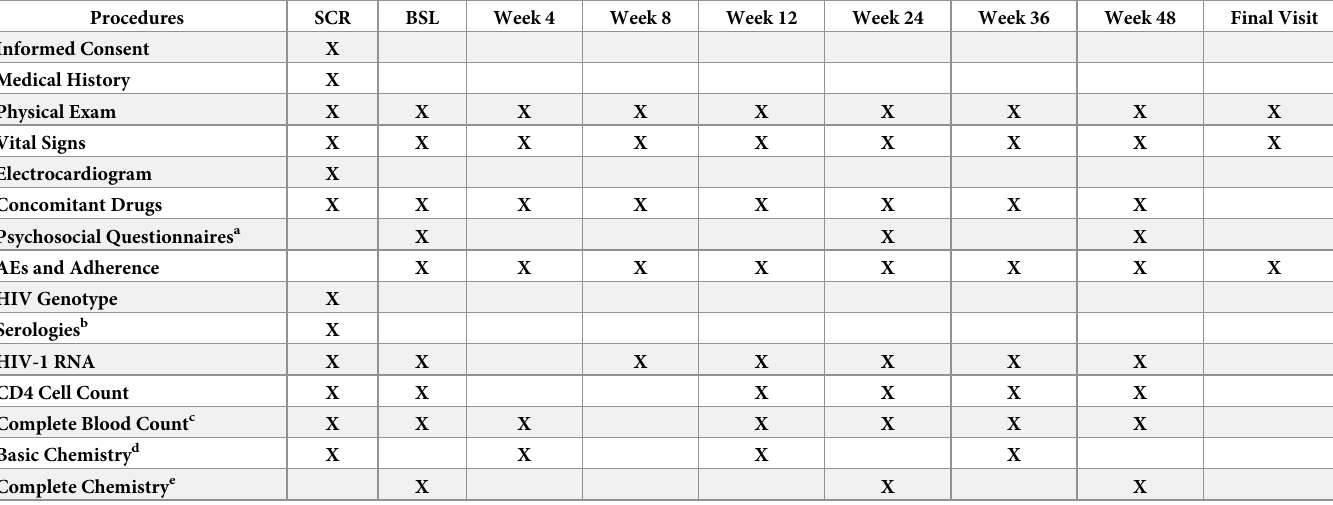
Abbreviations: SCR, screening; BSL, basal a Socio-demographic questionnaire, suicidal ideation, AUDIT, DAST-10. b HBV anti-core, HBVsAg, HCV IgG, VDRL. c Hemoglobin, hematocrit, erythrocytes, leukocytes, thrombocytes, neutrophils, basophils, lymphocytes, monocytes, reticulocytes, MCV, MCH, MCHC, platelets, prothrombin time, activated thromboplastin time.